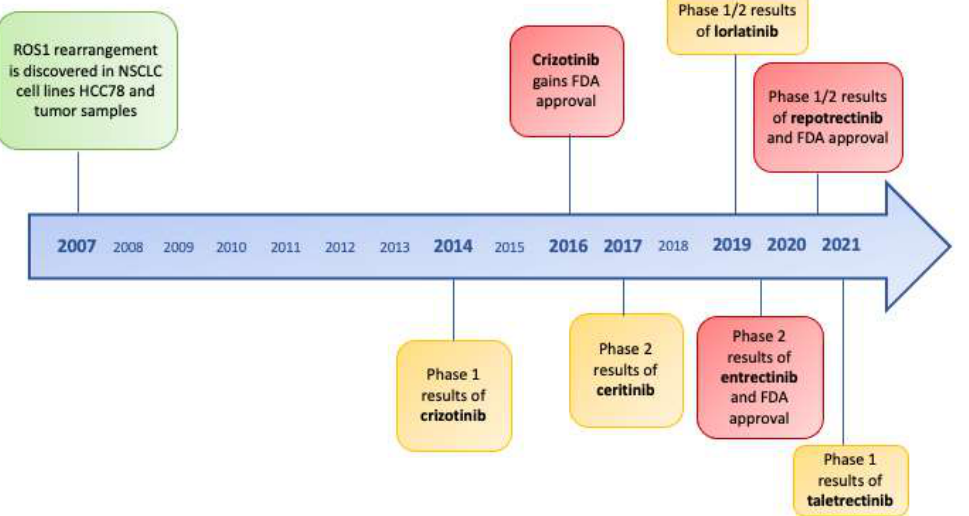
Figure 2. Timeline of ROS1 tirosine kinase inhibitors and FDA approvals since discovery of ROS1 -rearrangements in non-small-cell lung